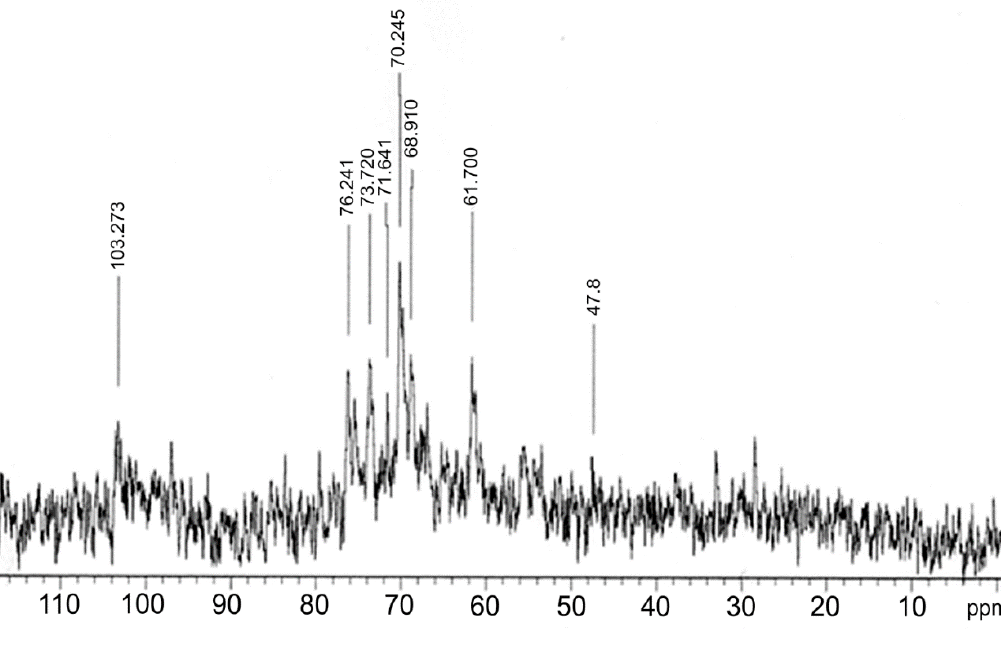
Figure 2. 13 C NMR spectroscopy of Polyporus dermoporus glucan-protein